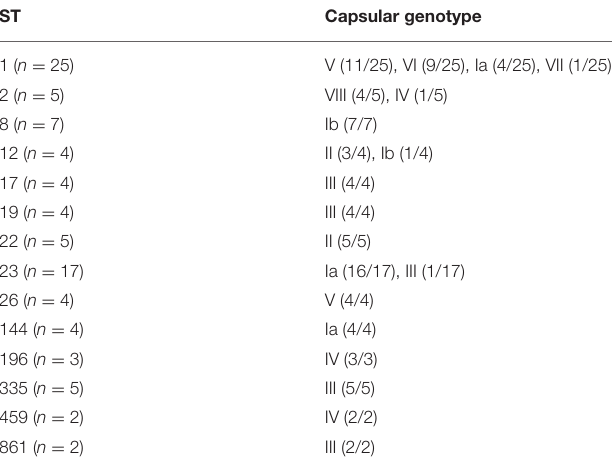
TABLE 6 | Association of MLST sequence types (ST) to capsular genotype. ST Capsular